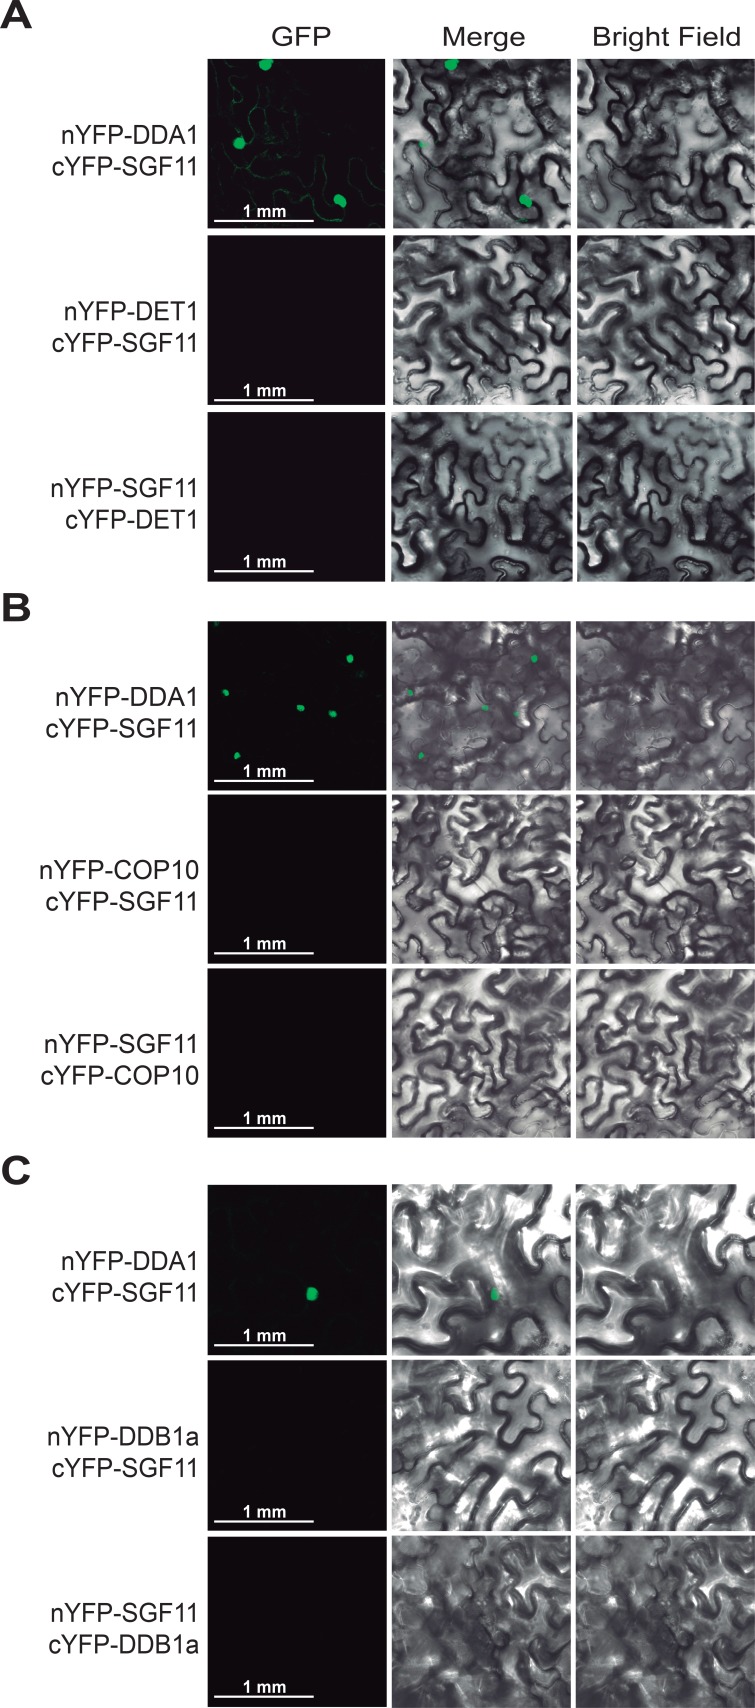
SGF11 in vivo association with the C3D complex occurs through direct interaction with DDA1.BiFC analysis of protein-protein interactions between SGF11 and the C3D protein component DET1 (A), COP10 (B) and DDB1a (C). Live fluorescence imaging of Nicotiana leaves was performed 72 hr after dual transfection of plasmids expressing the indicated translational fusions. Merged images of GFP (left) and bright field (right) channels are shown (middle).